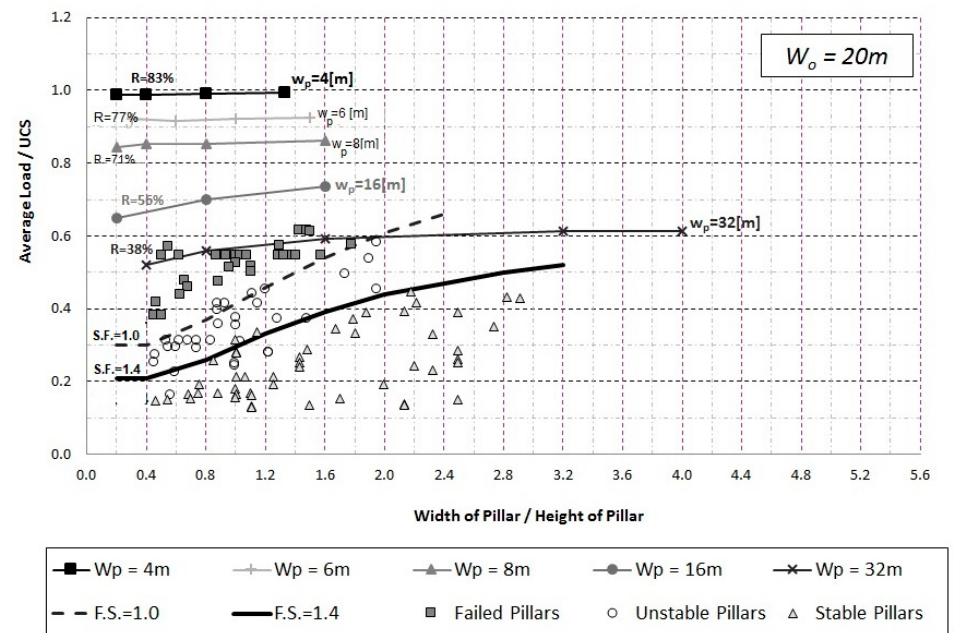
Figure 10. Empirical stability chart and modeling results—failure envelopes for different pillar widths W p .